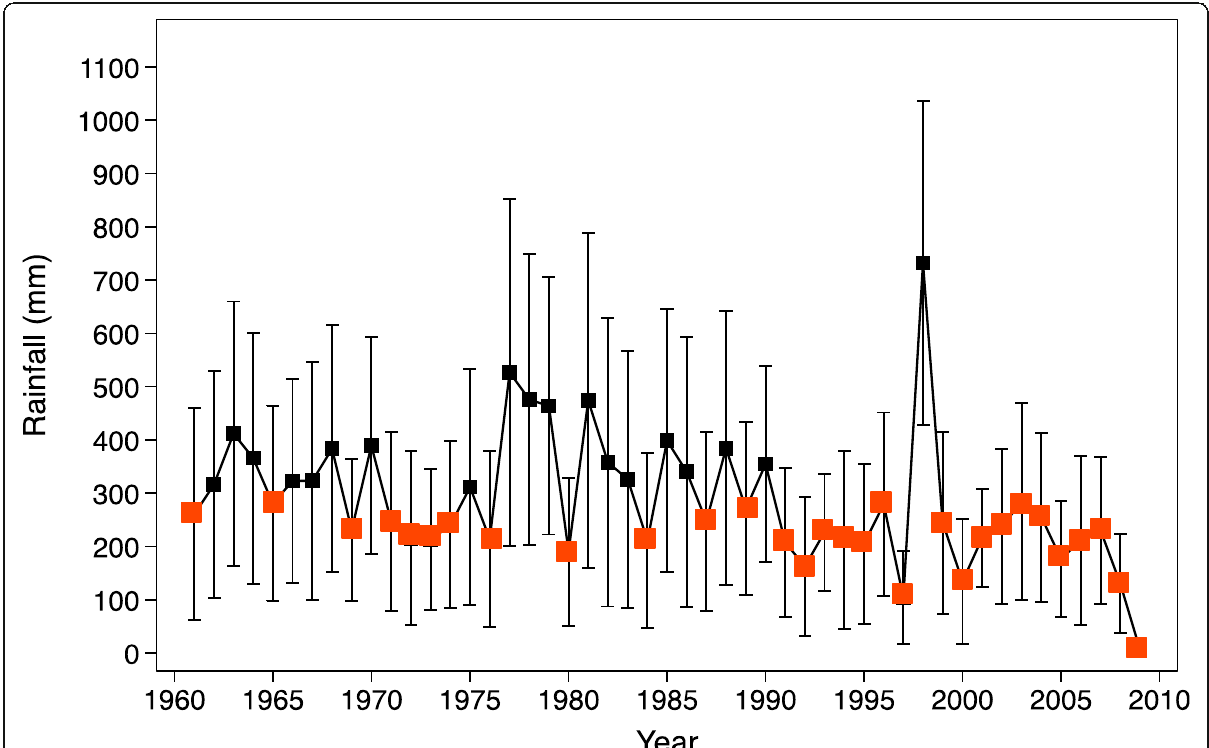
Figure 7 Fifty years of rainfall data (1960 to 2010) from northern Laikipia, Kenya. The black boxes (annual mean rainfall) indicate years where rainfall was above 300 mm/year whereas the orange boxes (again, mean annual rainfall) indicate years where rainfall was below 300 mm/year. Capped bars indicate standard deviation around the